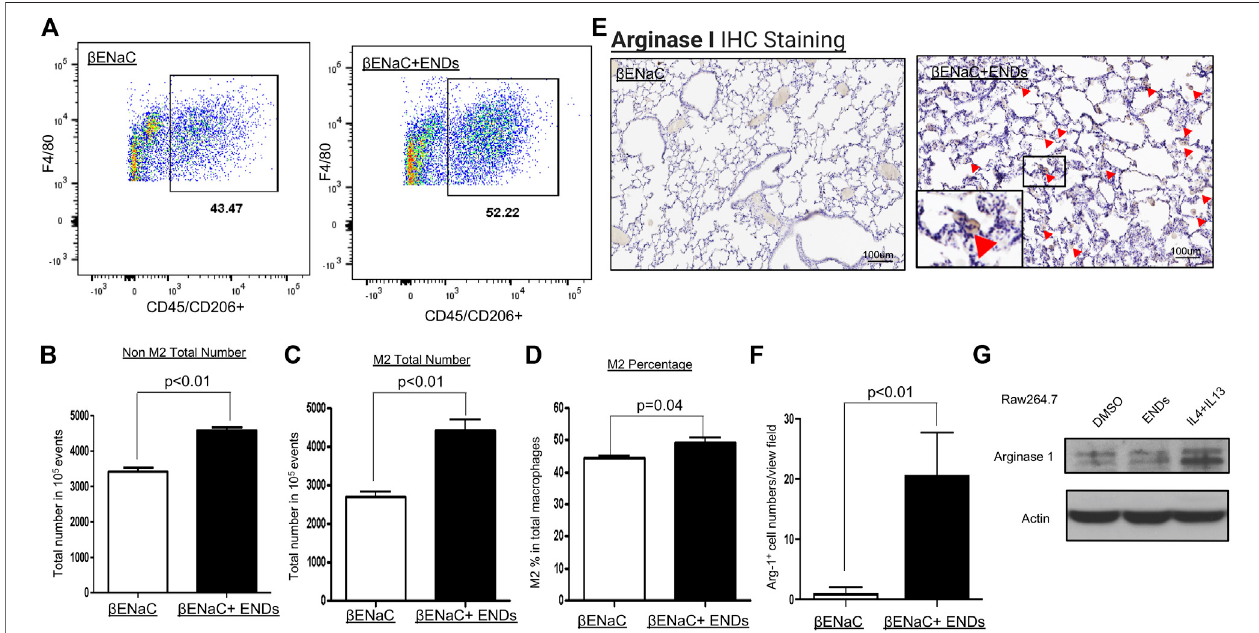
FIGURE4| E-cigaretteincreasesthepopulationofM2phenotypeofmacrophages. (A) FACSanalysisofthecellpopulationofF4/80 + CD206 + M2macrophagesin lung tissues of β ENaC mice with or without ENDS exposure ( n (cid:1) 3 per group). The M2 macrophages were pre-gated on live CD45 + cells. (B) Quanti fi cation of FACS analysisofCD45 + F4/80 + CD206 - non-M2macrophagecellnumberinlungtissuesof β ENaCmicewithorwithoutENDSexposure. (C) Quanti fi cationofFACSanalysisof CD45 + F4/80 + CD206 + M2 macrophage cell number in lung tissues of β ENaC mice with or without ENDS exposure. (D) Quanti fi cation of FACS analysis of CD206 + CD45 + F4/80 + M2phenotypepercentageinCD45 + F4/80 + totalmacrophagesinlungtissuesof β ENaCmicewithorwithoutENDSexposure. (E) Representative imagesof immunohistochemical (IHC) staining of Arginase I in lung tissues of β ENaC mice with or without ENDS exposure. The inset indicates the enlarged image of the boxed area showing positive staining. (F) Quanti fi cation of IHC staining of Arginase I as in (E) . The positive staining areas were calculated as percentages of total area, using fi ve randomly selected sections per mouse, a total of four mice in each group. (G) Representative blots showing the expression level of Arginase I after indicated treatments. Actin was used as an internal control. Raw264.7 were treated with DMSO or ENDS (50 mg/ml) or IL-4+IL-13 (IL-4 20 ng/ml; IL-13 20 ng/ml) for 48 h and harvested for analysis of protein expression by western blot. Columns and error bars represent means ±